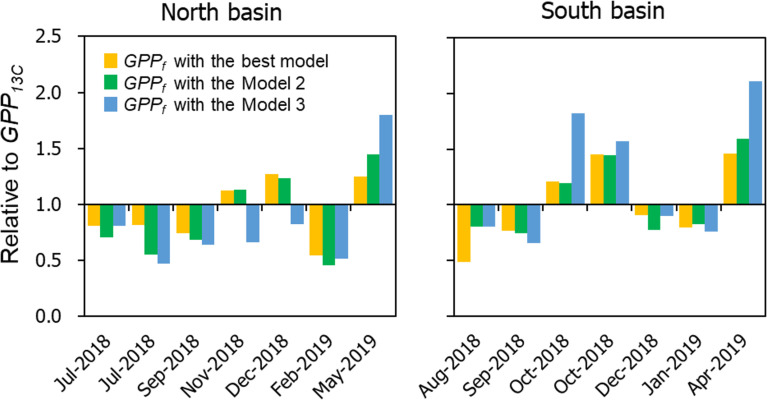
Relative GPPf estimated by ETRPSII with the Фe,C models against the GPP13C on each sampling date for North and South basins.